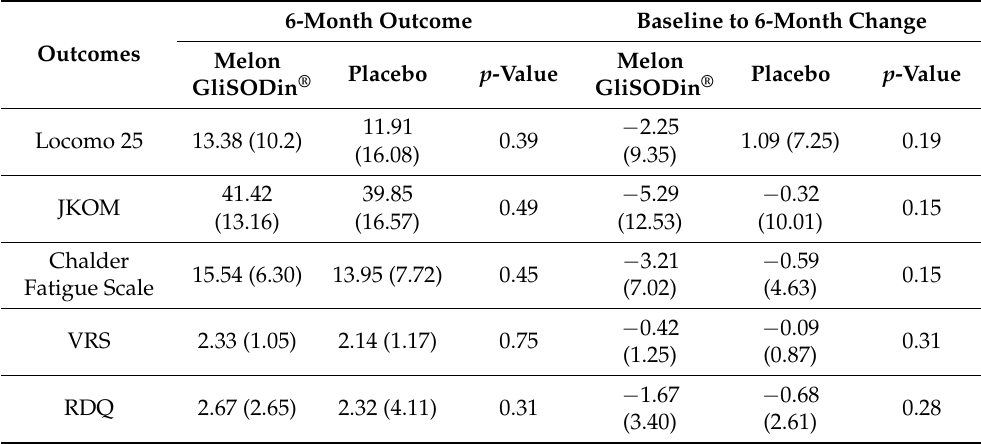
Table 2. The effects of Melon GliSODin ® on symptom severity comparison between the GliSODin ( n = 24) and placebo ( n = 22) groups after 6